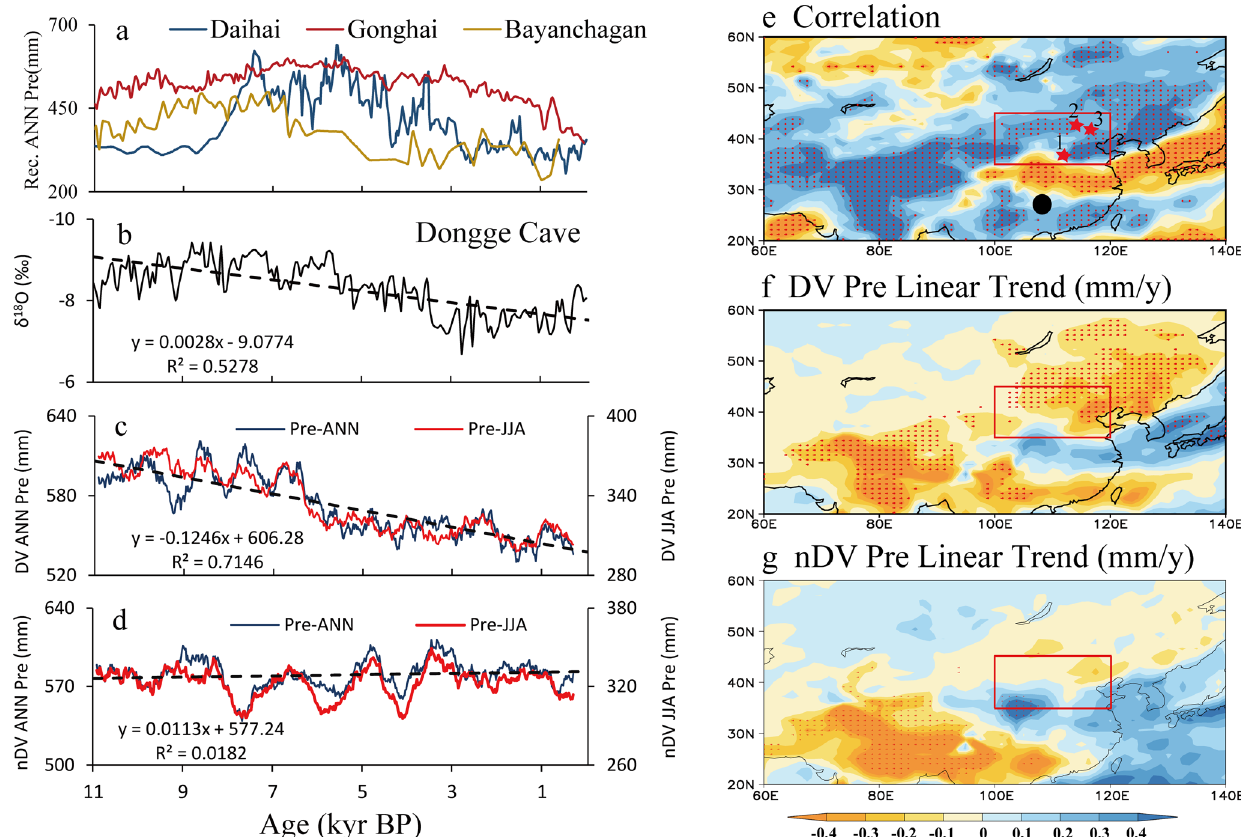
Fig. 1 Holocene precipitation over East Asia. a Holocene annual precipitation (ANN Pre) time series reconstructed from pollen records at Gonghai, Daihai and Bayanchagan lakes 4,31,32 for northern China interpolated onto 20-yr intervals; b Stalagmite oxygen isotope record from Dongge Cave 4,6 interpolated onto 20-yr intervals; c DV-simulated annual (blue line, Pre-ANN) and summer (red line, Pre-JJA) precipitation series for northern China in the Holocene; d Same as c but for nDV-simulated. e Distribution of the temporal correlation between pollen-reconstructed precipitation and DV annual precipitation; f Distribution of linear trends of DV annual precipitation; g Same as f but for nDV annual precipitation. The dashed black lines in a – d indicate linear trends from 11 kyr BP to the present. The red star and black dot in e represent the location of Gonghai(1), Daihai(2), Bayanchagan(3) lakes and Dongge Cave respectively. In e and f , areas exceeding the 99% con fi dence level are stippled (the same below), and the enclosed rectangles represent the study region of northern China (100 – 120 °E, 35 – 45 °N). e – g are generated using GrADS v1.5.1.12 71